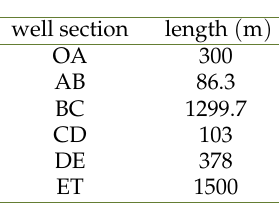
Table 7. Section length of conventional six-section well